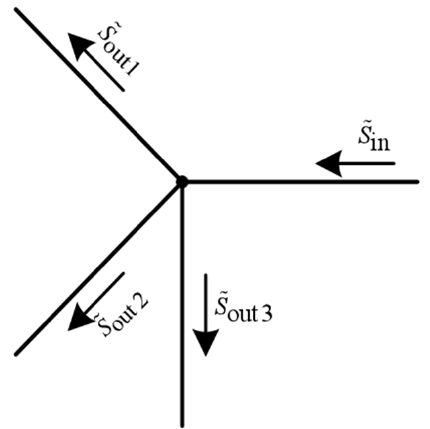
Figure 5. Power flow topology.